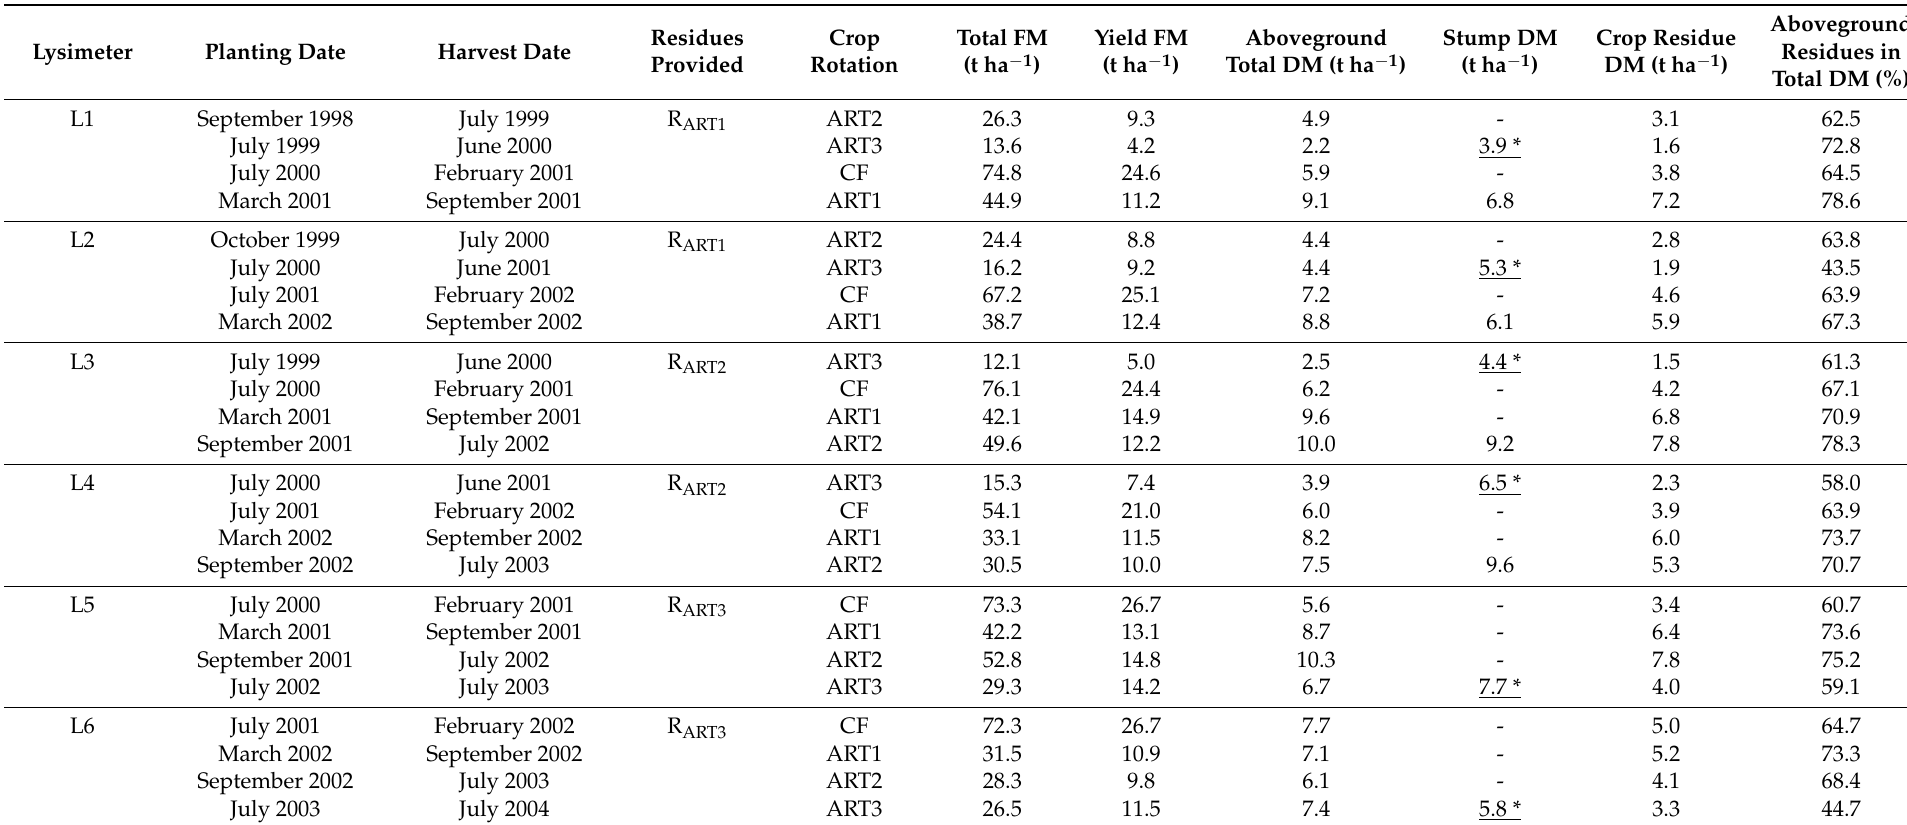
Table 2. Artichoke (ART) and cauliflower (CF) total fresh-matter (FM) in biomass (belowground + aboveground) and yield (heads), along with dry matter (DM) amounts and percentages returned to the soil as